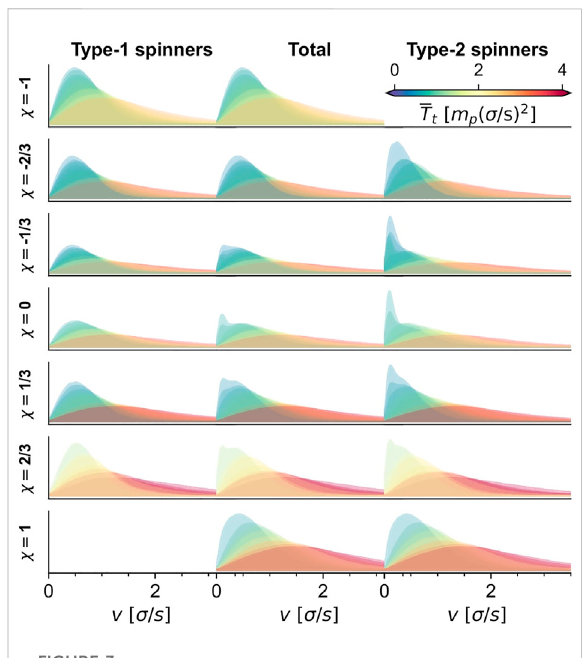
FIGURE 3 Marginal distribution functions for the translational f r ,w ( v ) (the subindices r , v , w indicate an average over those quantities). Each row contains the distribution functions for all experiments with a given relative species density. Line colors represent each experiment ’ s average kinetic energy T t